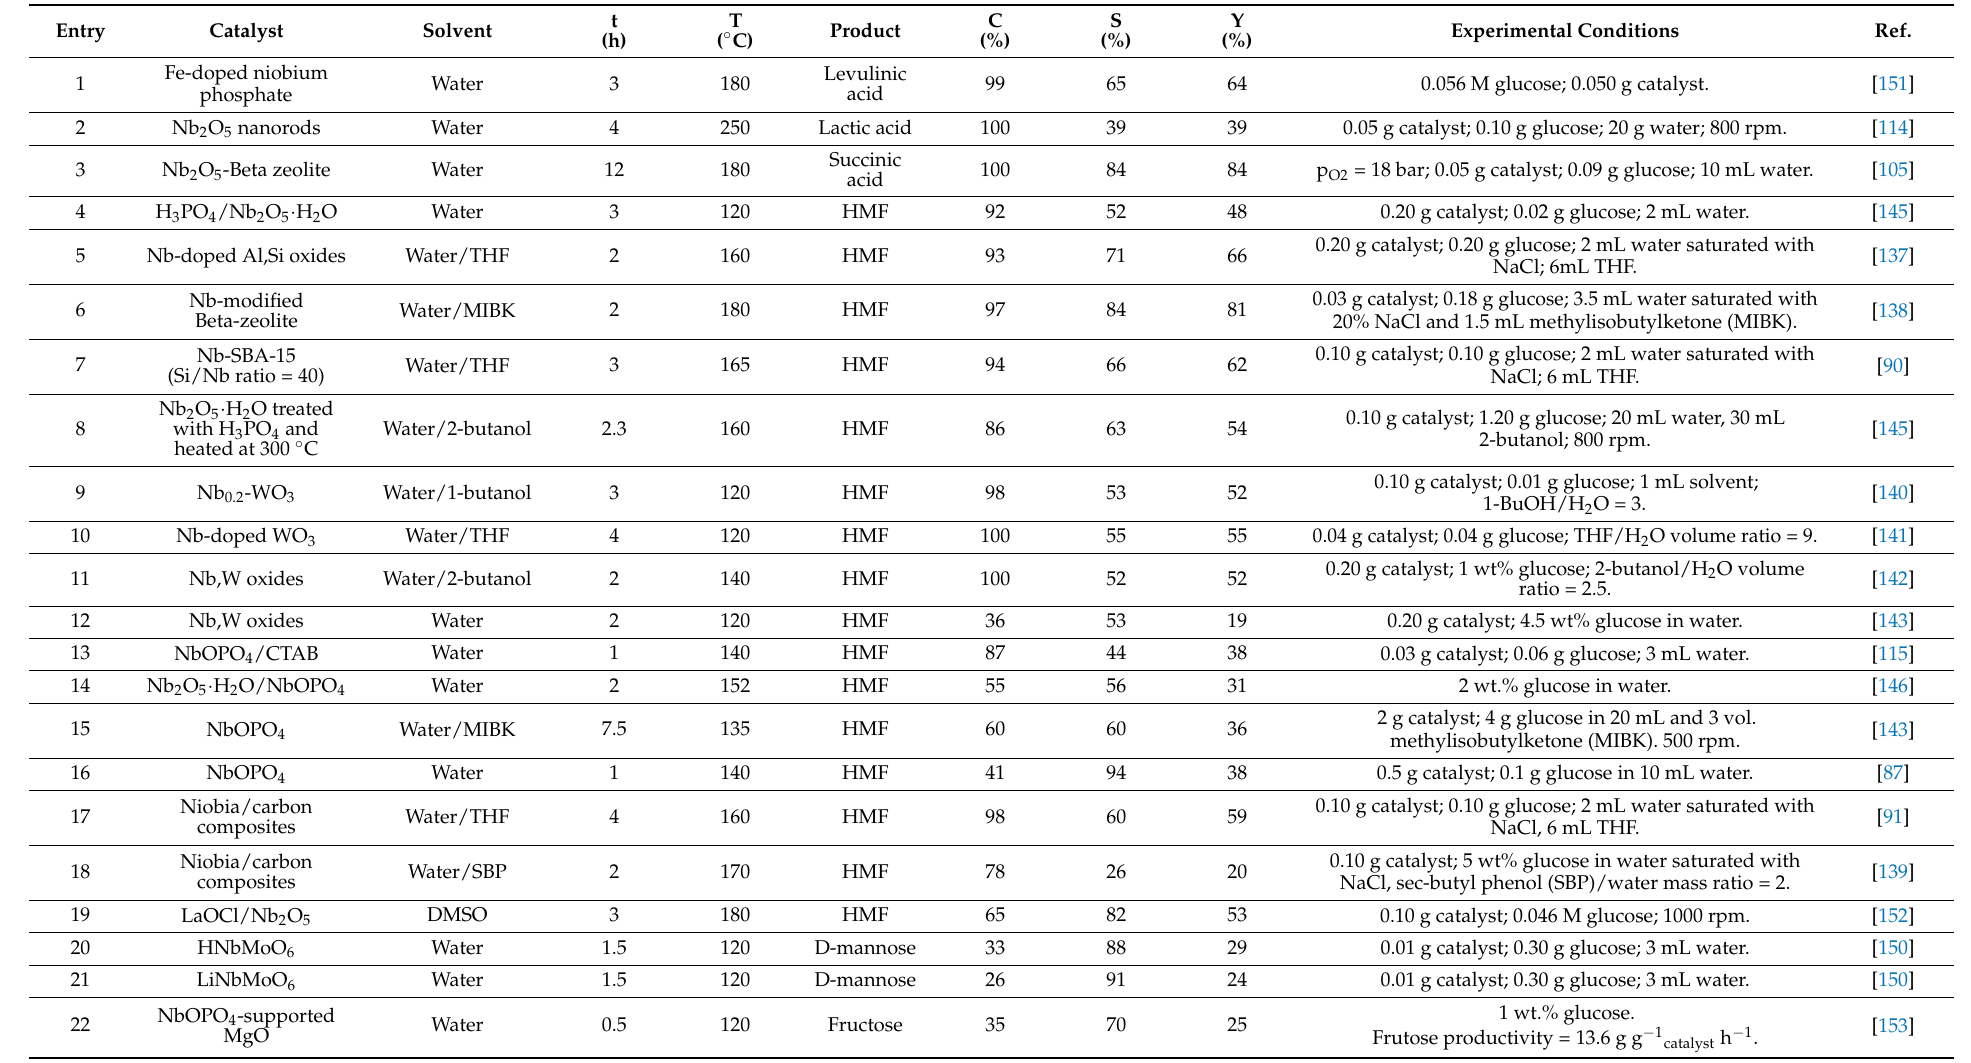
Table 4. Performance of niobium-based catalysts for the conversion of glucose into different products—from 2010 to